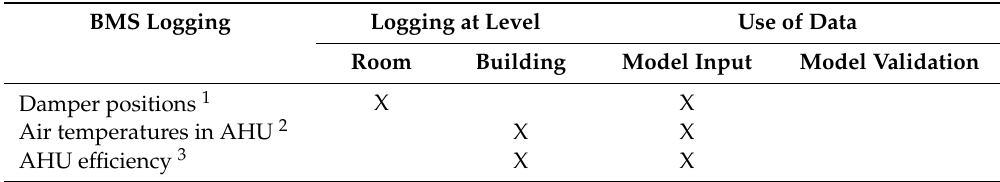
Table 3. Overview of Building Management System (BMS) logging.